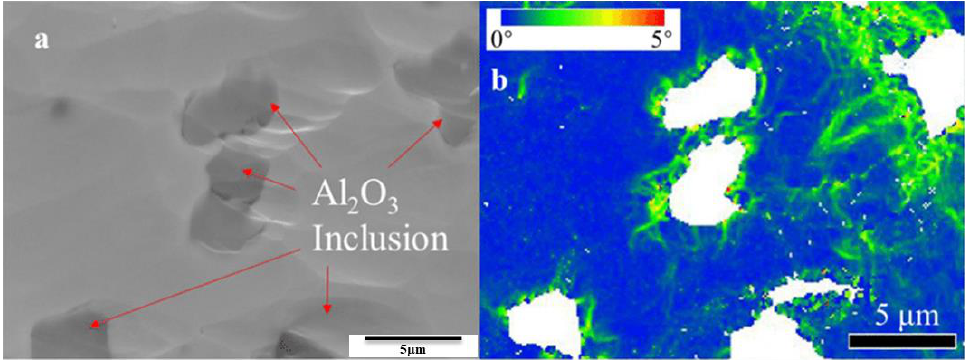
Figure 2. SEM image and KAM image of Al 2 O 3 inclusion region. ( a ) FE-SEM image; ( b ) KAM image of the same region as shown in ( a ) [13]. Reproduced with permission of Elsevier, copyright